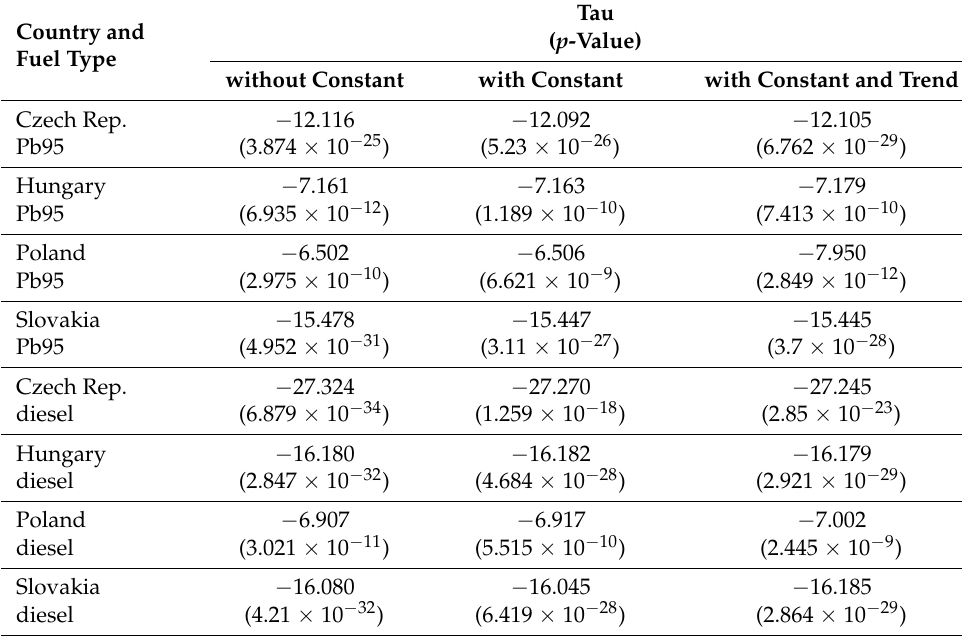
Table 5. The ADF test results for fuel log-returns.